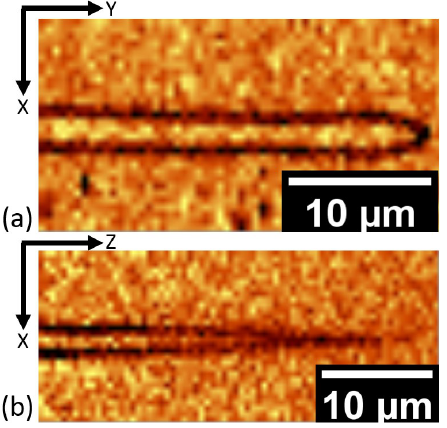
Figure 4. CRM images of the stripe domains after partial polarization reversal: ( a ) view on the polar surface, ( b ) view at the XZ section.